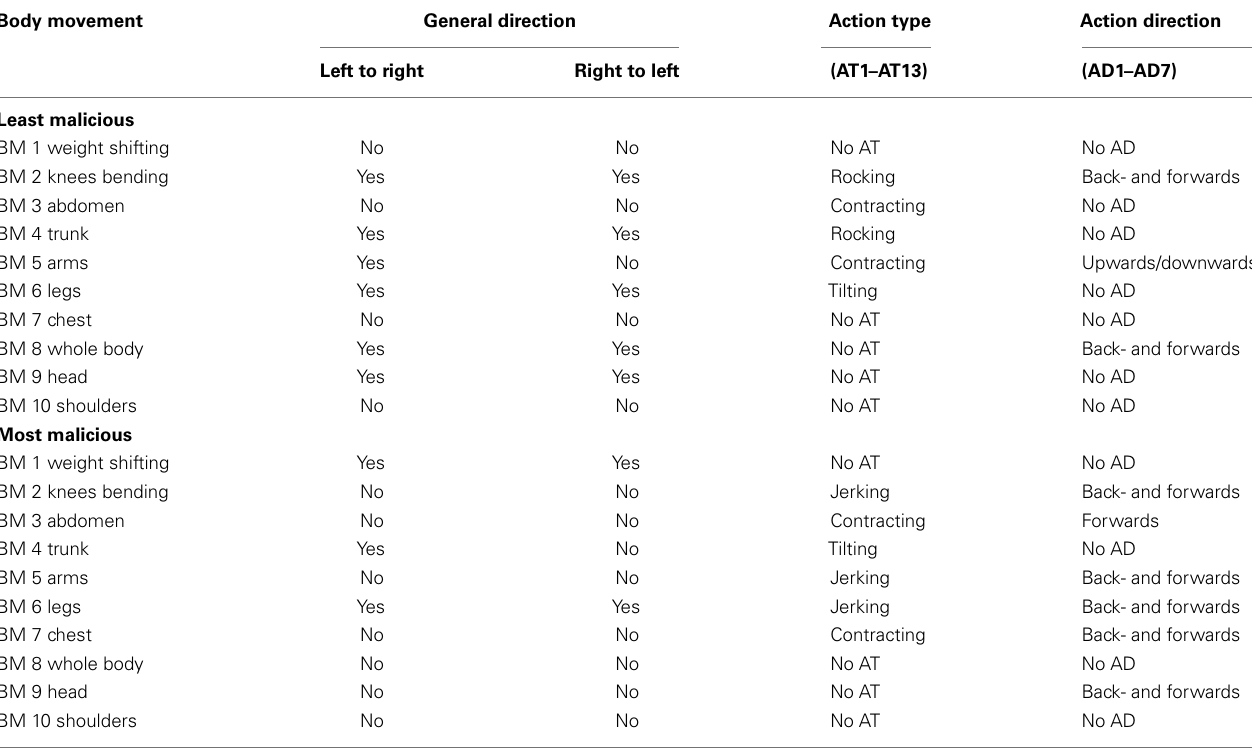
Table 1 |The body movement, general direction, action type, and action direction for laughter body movement stimuli being perceived as least and most malicious by the gelotophobes